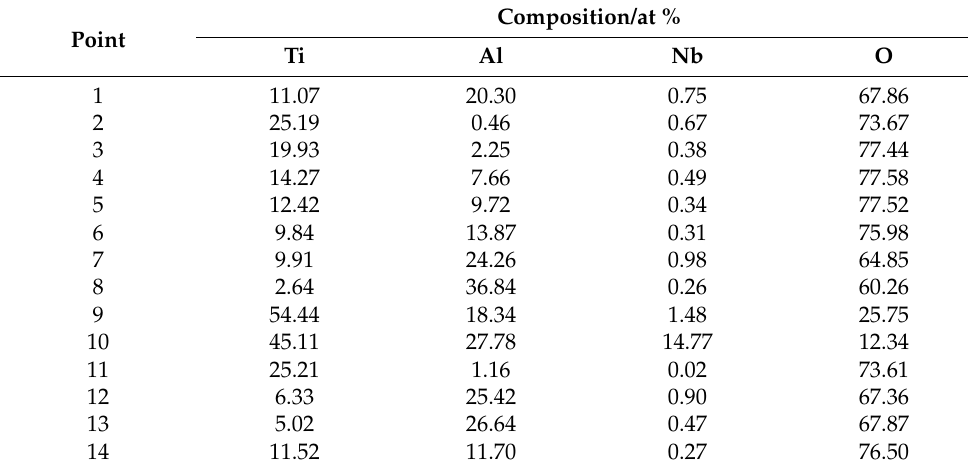
Figure 5. XRD diffraction spectra of the Ti ‐ 45Al ‐ 8.5Nb alloys after 1000 °C/100 h isothermal oxidized treatment ( a ) without and ( b ) with fluorine spray. Table 1. EDS results derived from the marked points in Figures 6 and